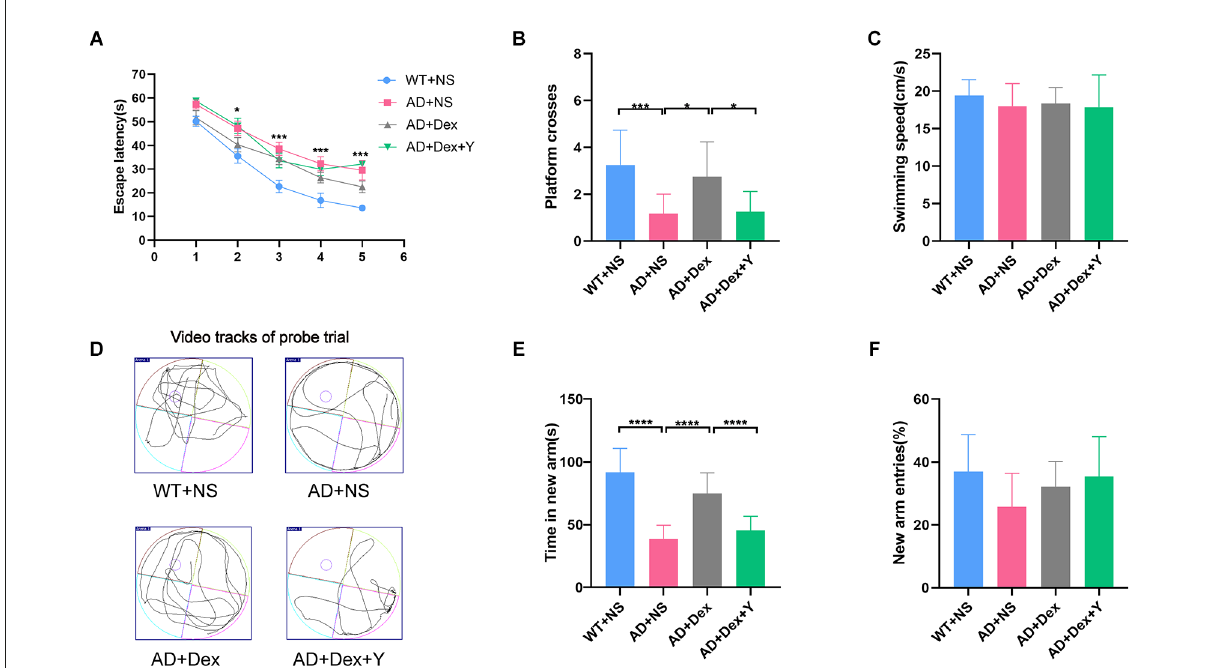
FIGURE1 Dexmedetomidine improves learning and memory ability in 5xFAD mice. The data from the Morris water maze (A–D) and Y maze (E,F) were recorded and statistically analyzed. Panel (A) represents latency during the acquisition phase (means ± SEM, two-way repeated measures ANOVA and Bonferroni post-hoc test, * p < 0.05, AD+NC compared to the WT+NC group). Panel (B) represents the number of animals crossing the platform. Panel (C) represents swimming speed by mice in the target quadrant during the probe trial. Panel (D) represents video tracks of the probe trial. Panel (E) represents time spent in the new arm of the Y maze. Panel (F) represents the percentage of new arm entries in the Y maze (means ± SEM, ANOVA, Tukey’s test, * p < 0.05, *** p < 0.001, **** p < 0.0001). n = 12 in each